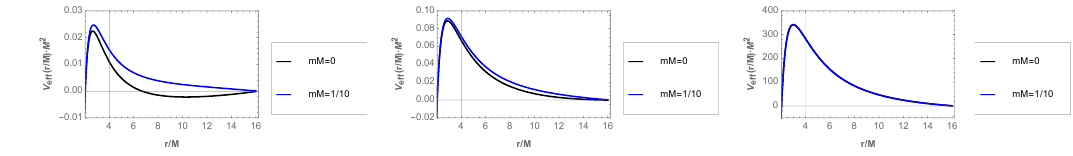
Figure 2 . The effective potential V eff M 2 as a function of r/M , for uncharged scalar fields with ‘ = 0 (left panel), ‘ = 1 (center panel), and ‘ = 100 (right panel) with Λ M 2 = 0 . 01 , and Q/M = 1 / 10 . Here r H /M ≈ 2 . 023 , and r Λ /M ≈ 16 . 218